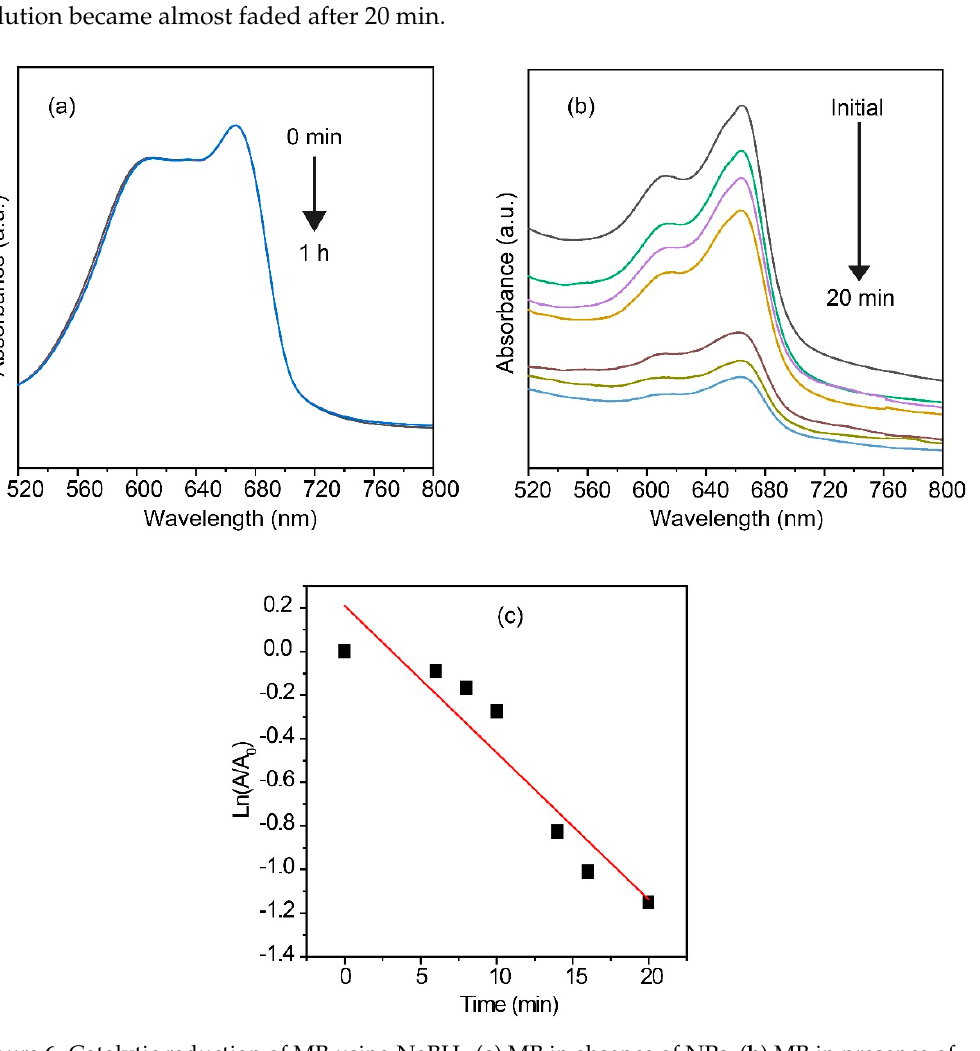
Figure 6. Catalytic reduction of MB using NaBH 4 ( a ) MB in absence of NPs, ( b ) MB in presence of NPs, ( c ) Ln (A/A 0 ) vs. time plot of MB reduction.